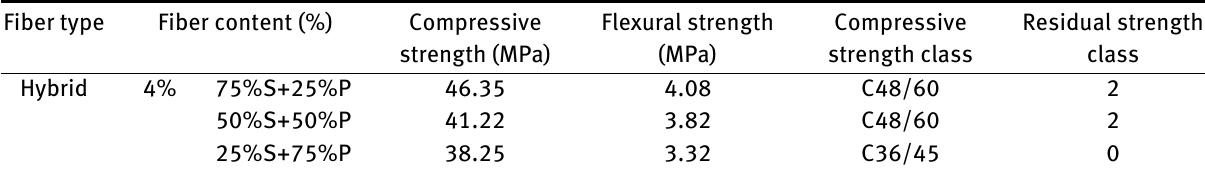
Table 5: The results obtained from the tests and the classification according to EFNARC Fiber